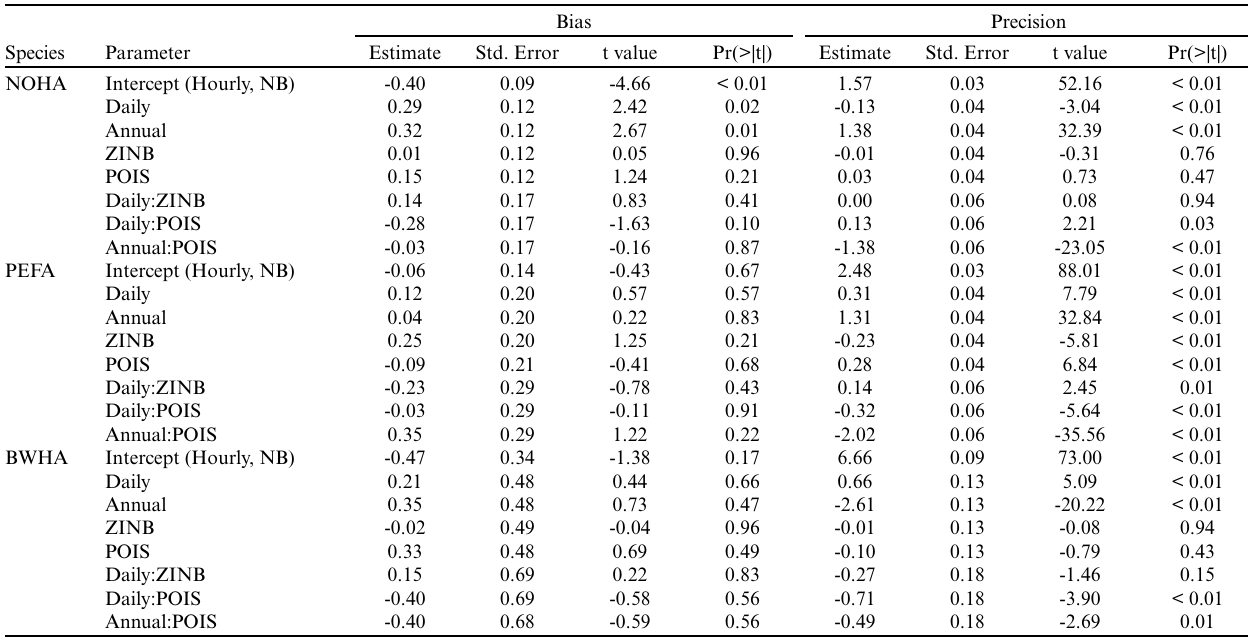
Table 1 . Parameter estimates from linear models (Gaussian distribution) that examined the influence of count type (hourly, daily, or annual), model structure (negative binomial [NB], zero-inflated NB [ZINB], or Poisson [POIS]), and their interaction on bias (estimated - simulated trend) or half-width of the credible interval (0.5×[upper credible limit - lower credible limit]) of trends estimated for datasets simulated to represent a commonly detected species (e.g., Northern Harrier, Circus cyaneus , NOHA), a rarely detected species with zero-inflated counts (e.g., Peregrine Falcon, Falco peregrinus , PEFA), or a super-flocking species with highly overdispersed counts (e. g., Broad-winged Hawk, Buteo platypterus ,